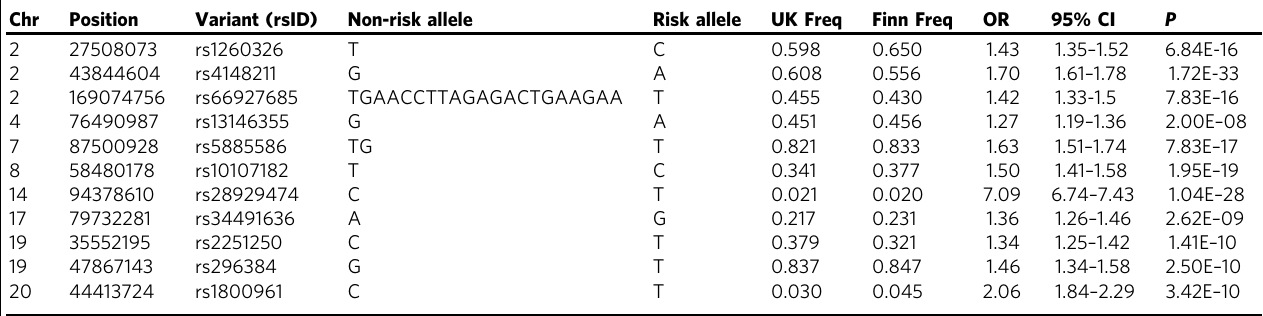
Table 1 Association statistics of the eleven loci achieving genome-wide signi fi cance ( P < 5 × 10 − 8 ) in the genome-wide association study meta-analysis of intrahepatic cholestasis of pregnancy